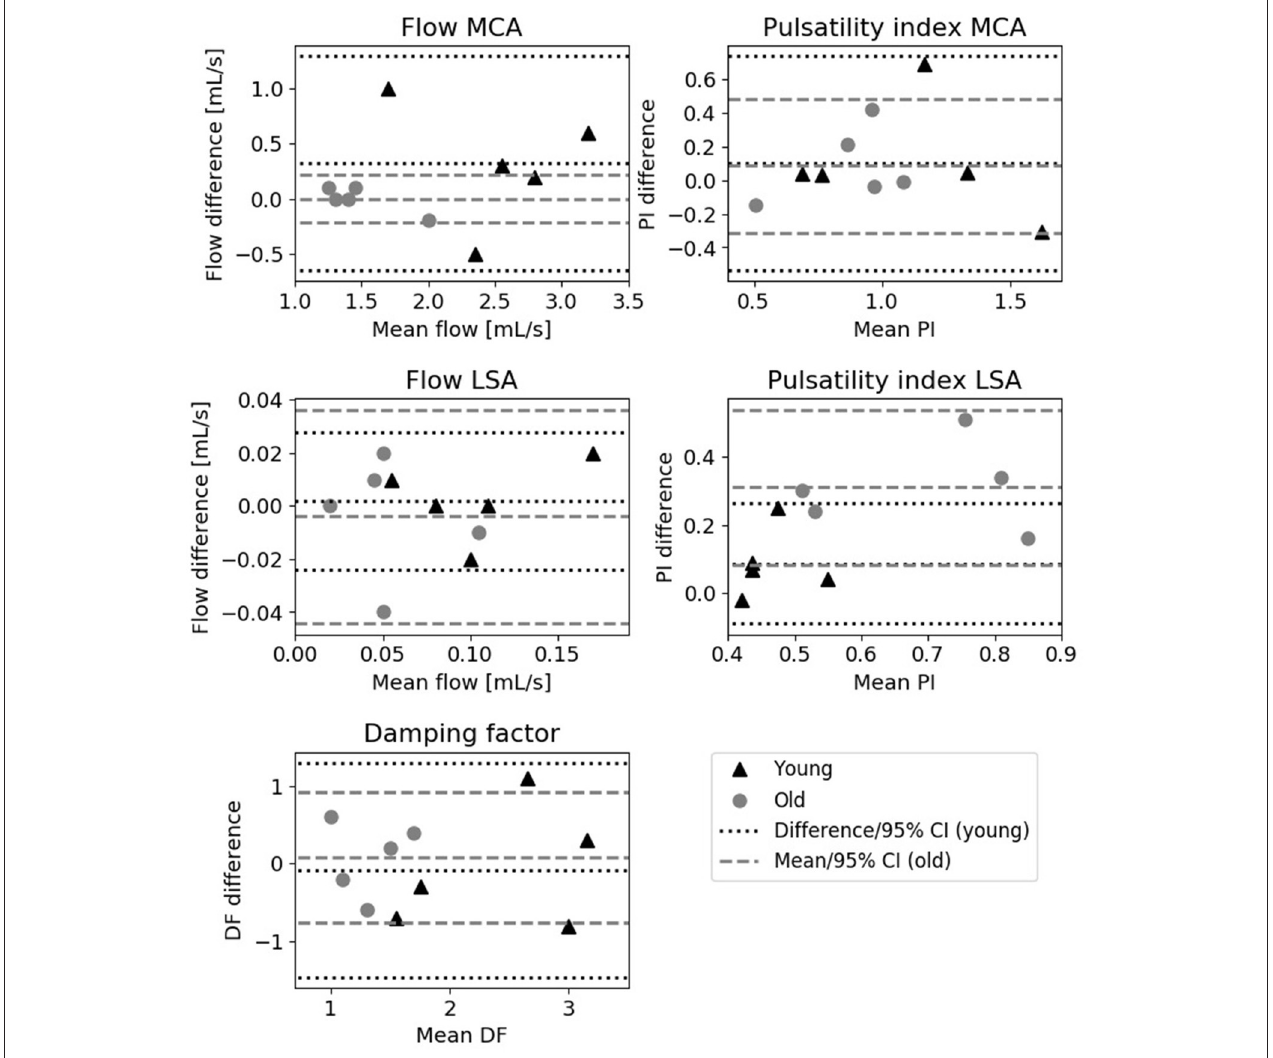
FIGURE 4 | Bland-Altman plots showing the difference between the two measurements vs. the mean. Depicted are the mean flow and pulsatility index of the MCA ( upper row ), mean blood flow and pulsatility index of the LSA ( middle row ) and damping factor measurements ( bottom row ) for young (triangles) and old (circles) subjects. The lines indicate the mean and 95% confidence interval of the